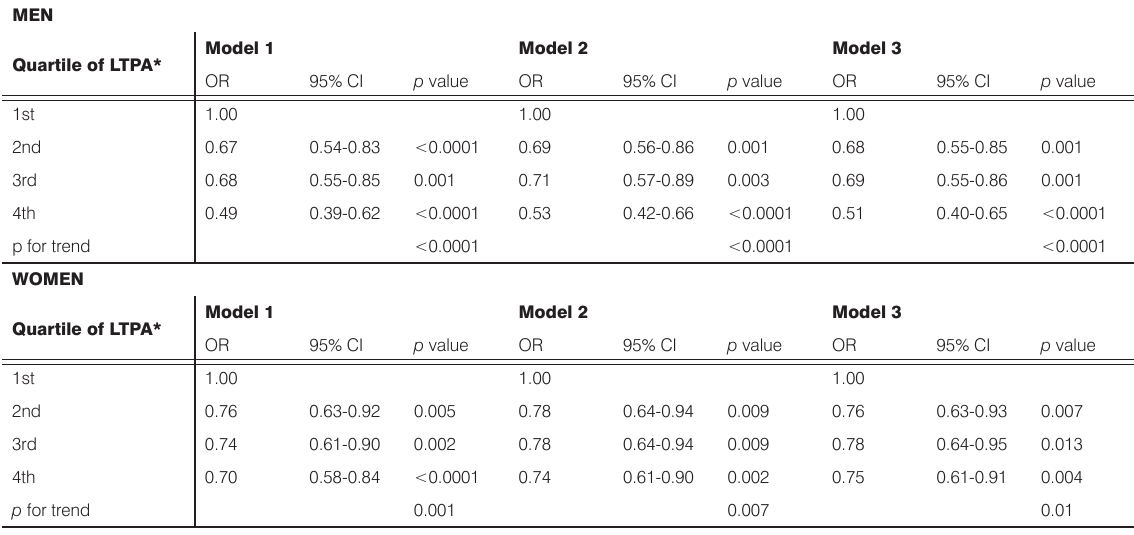
Table 3. Adjusted odds ratios of the metabolic syndrome in different levels of leisure-time physical activity MEN